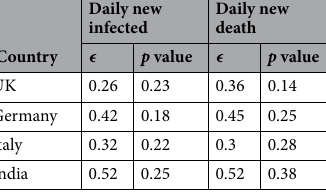
Table 1. p Values for daily new infected and dead for Class A–D representative countries between 11 Feb to 16 June